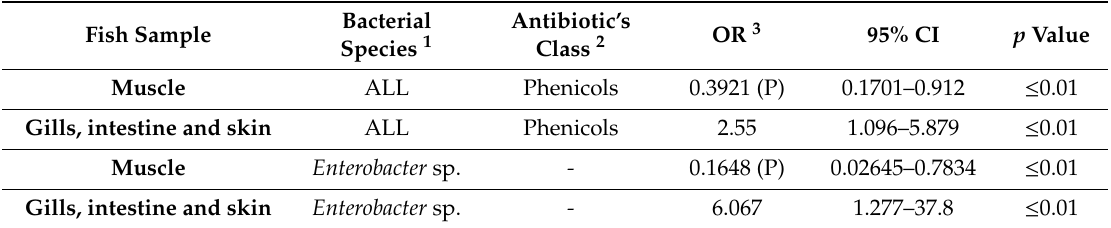
Table 5. Odds ratio (OR) and 95% confidence intervals (CI) ( p ≤ 0.05) from the analysis of negative and positive correlations between fish samples (muscle vs. gills, intestine and skin) and each bacterial species and non-susceptibility to di ff erent antibiotics